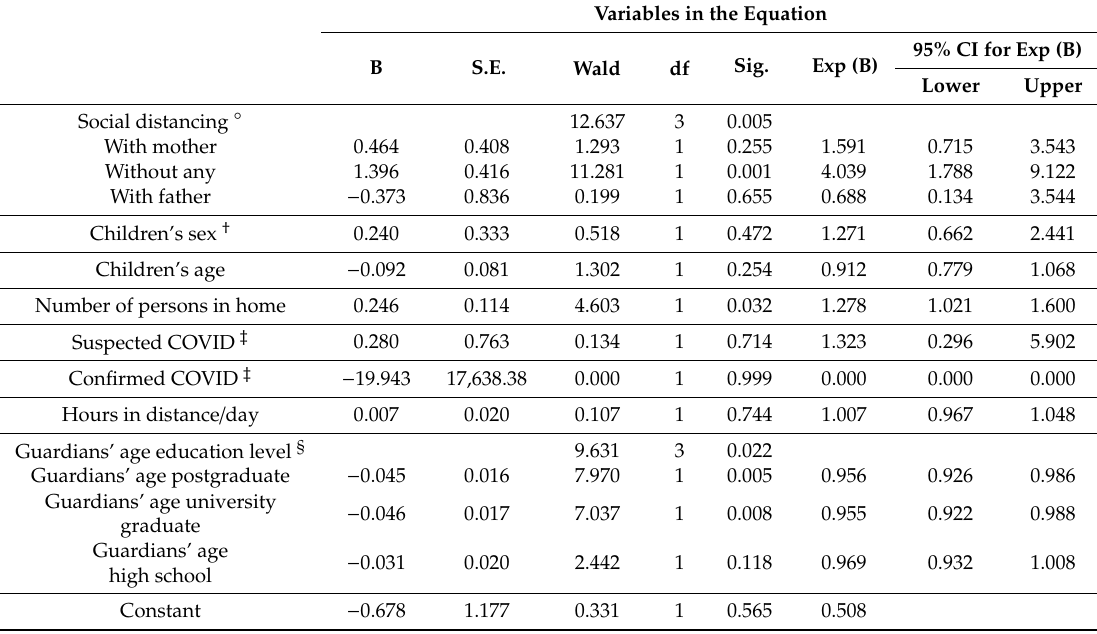
Table 4. Binary logistic regression for the CAQ scale.